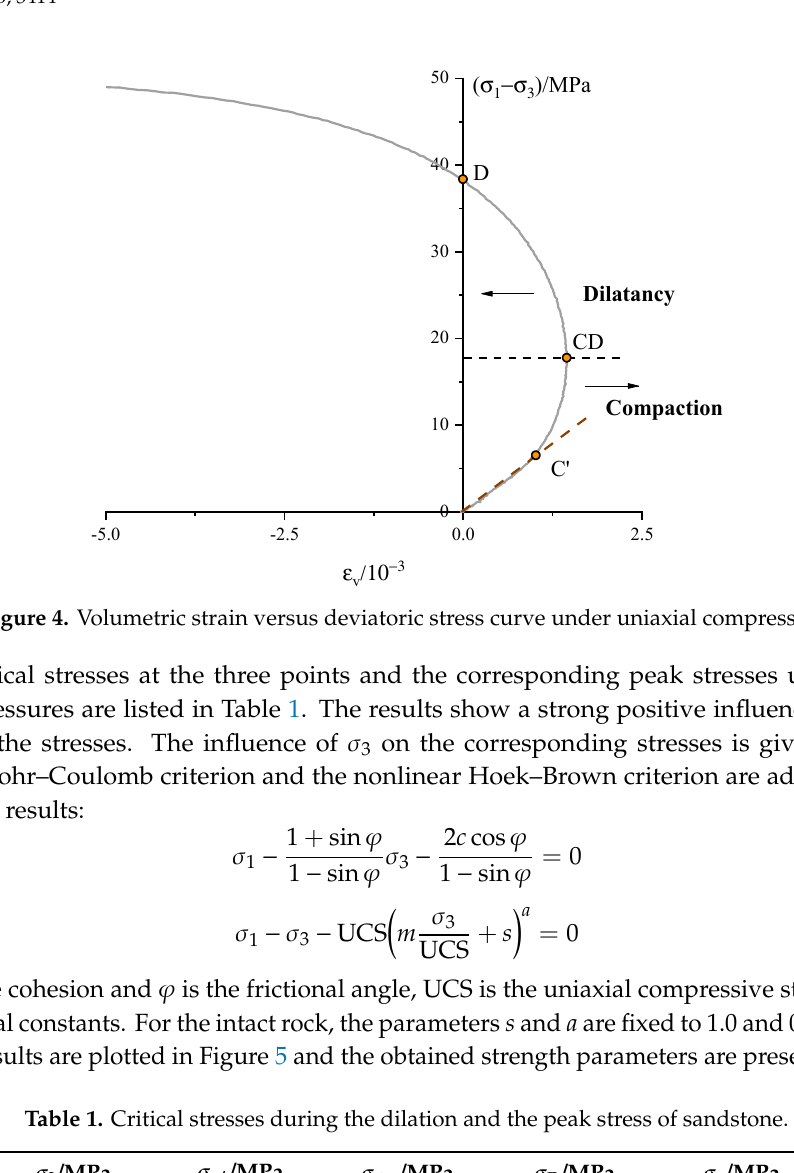
Table 1. Critical stresses during the dilation and the peak stress of sandstone